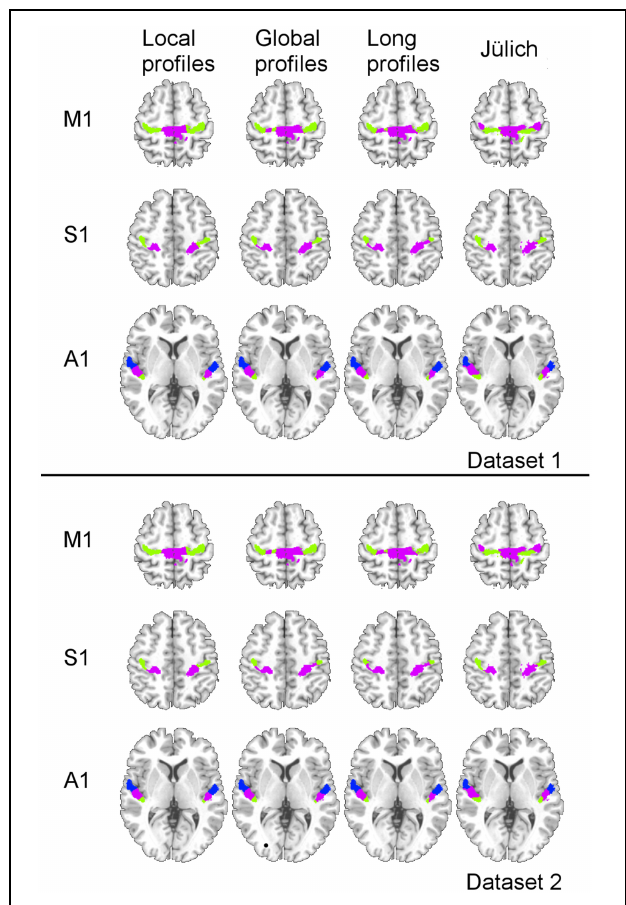
FIGURE 1 | Comparison of the MPM results using local, global, and long connectivity profiles with the cytoarchitectonic results from the SPM Anatomy Toolbox (FZ Jülich’s results).